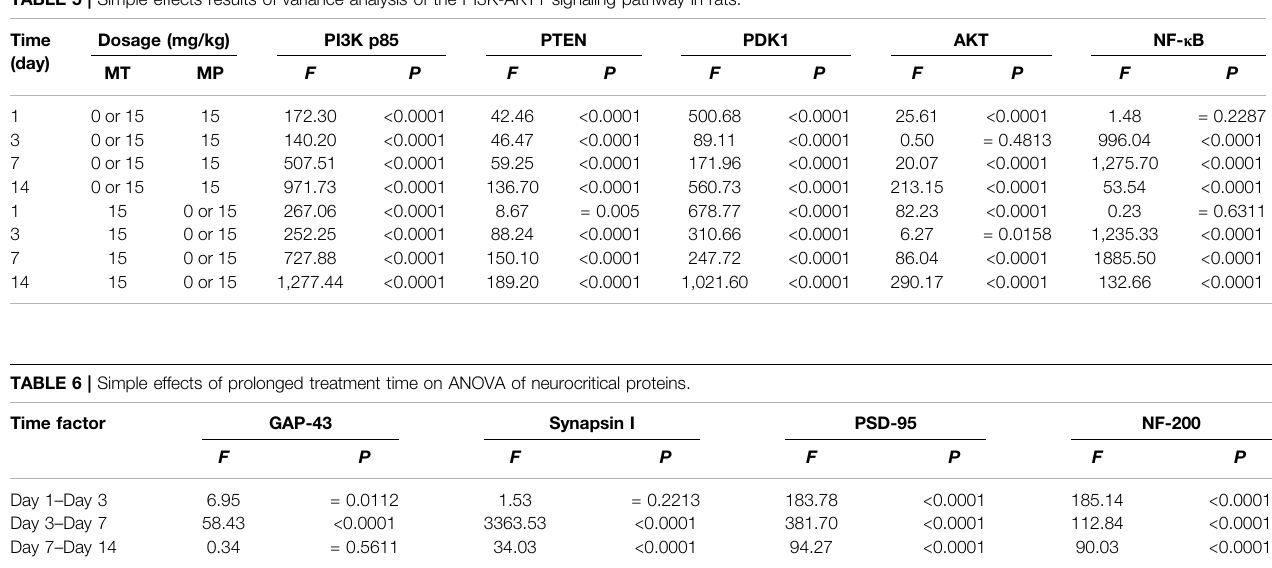
TABLE 5 | Simple effects results of variance analysis of the PI3K-AKT1 signaling pathway in rats.